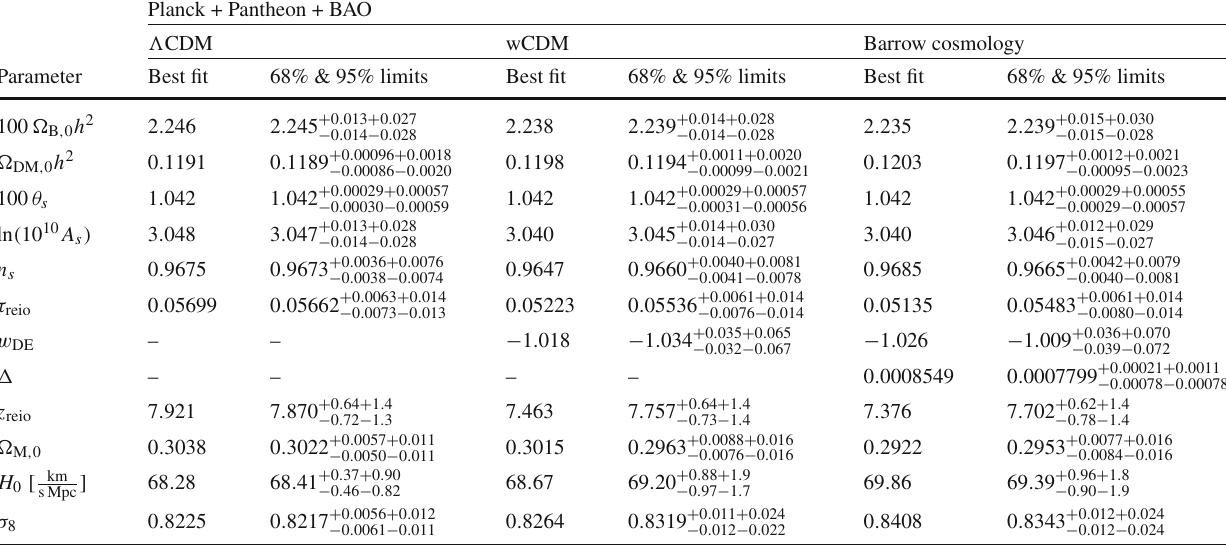
Table 1 Best-fit values and 68% and 95% confidence level intervals for cosmological parameters of (cid:3) CDM, wCDM, and Barrow cosmology, considering dataset (I)